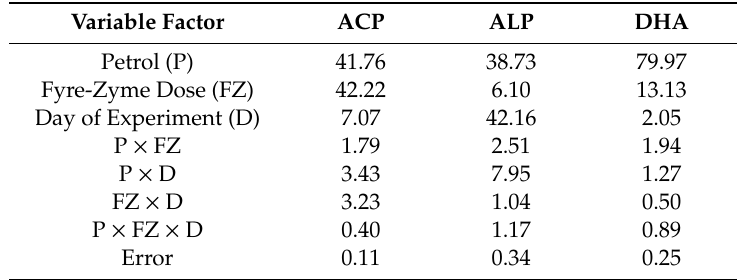
Table 7. Percentage share of observed variability factors η 2 on soil enzyme activities.